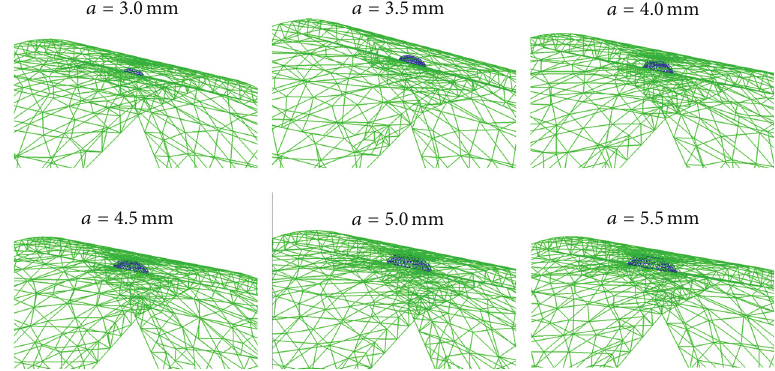
Figure 17: Growing shape and size of a longitudinal crack.